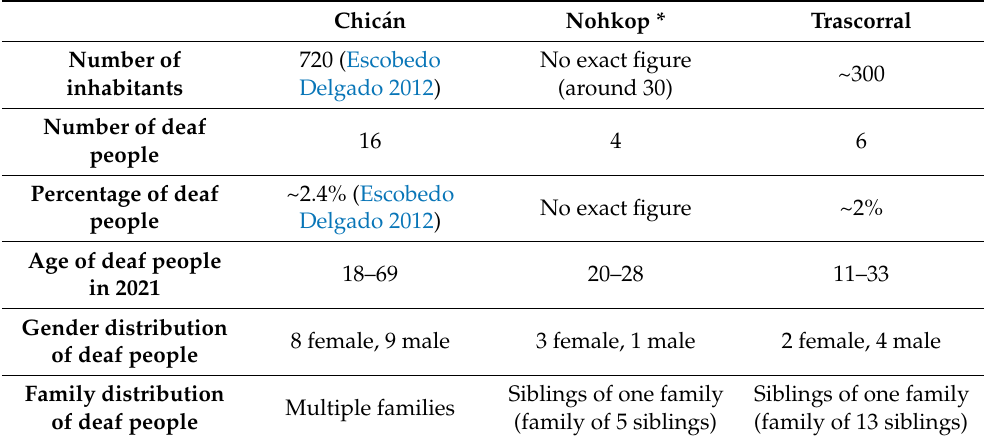
Table 1. Overview of the communities’